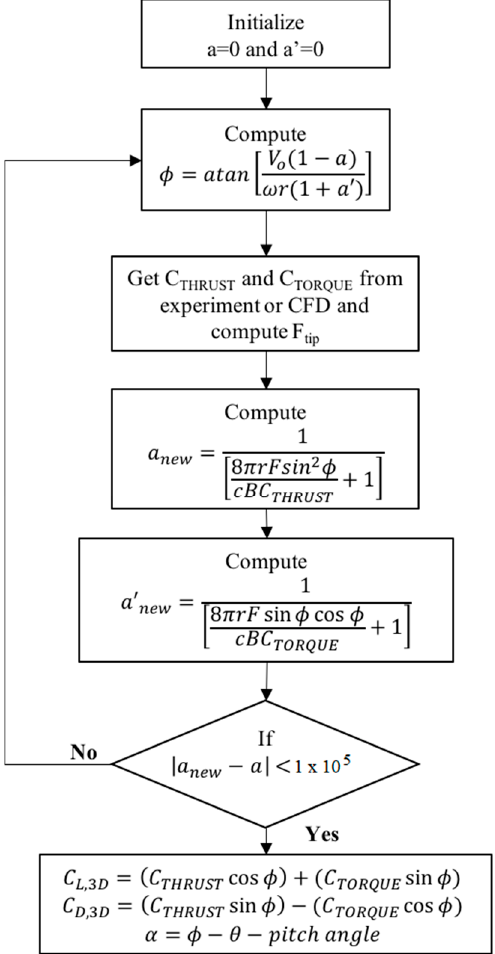
Figure 3. Inverse Blade Element Momentum (IBEM) method.